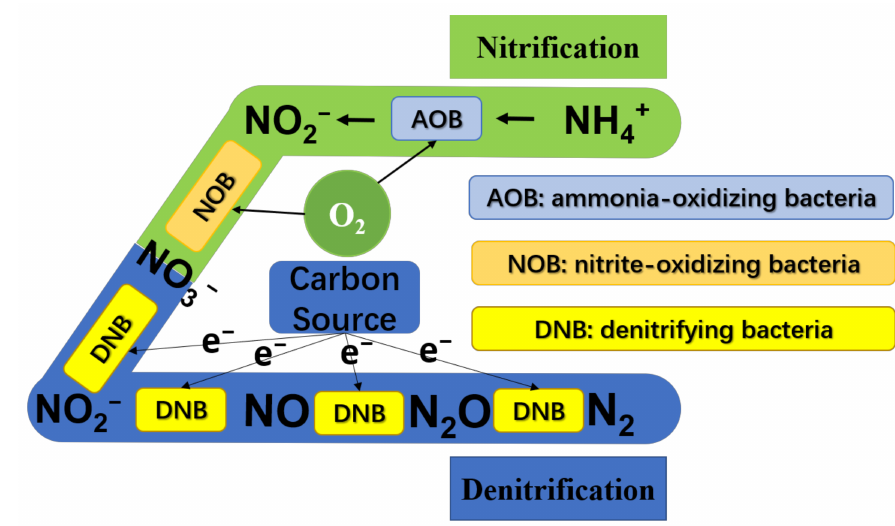
Figure 1. Typical pathway of biological nitrogen removal and involved